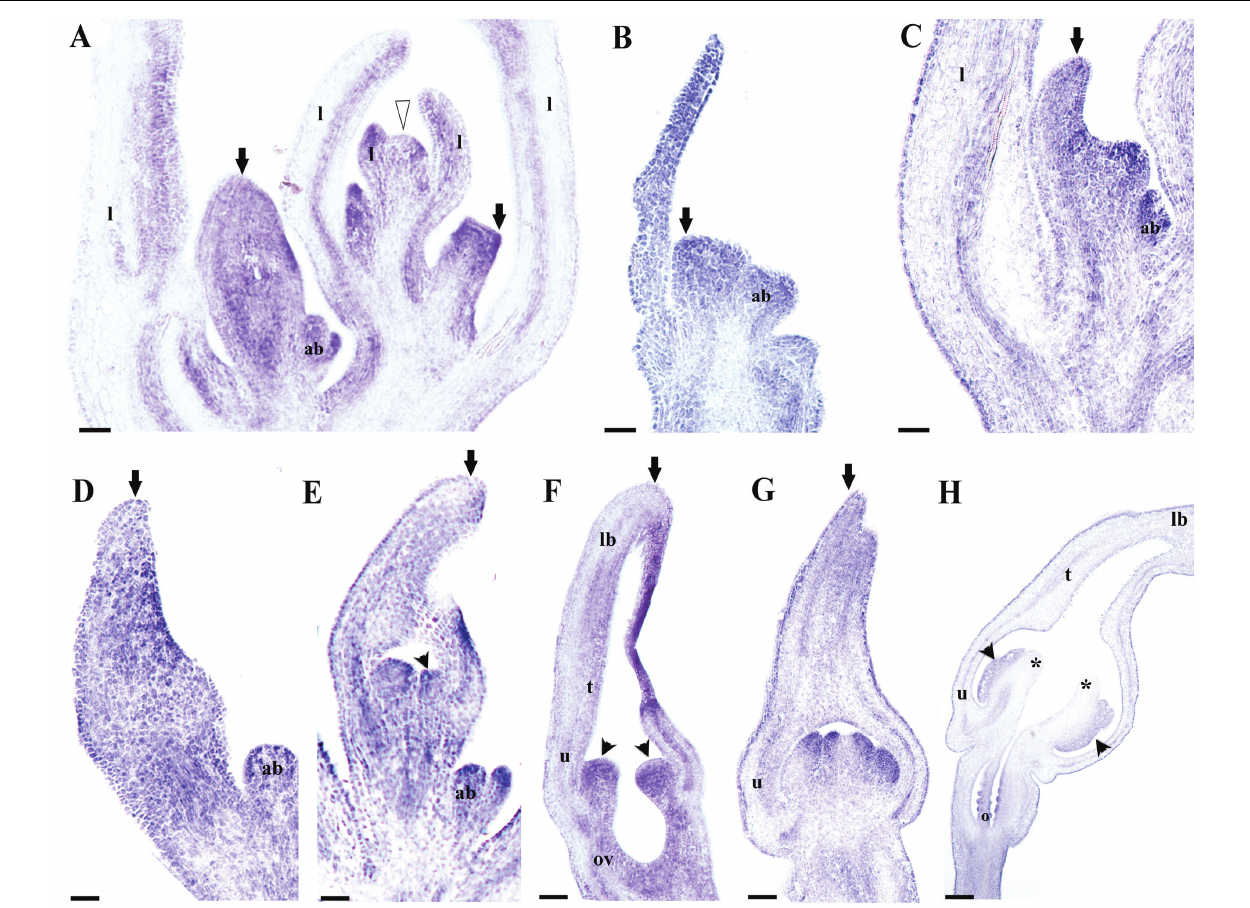
FIGURE 7 | In situ hybridization of AfimFUL. (A) Flowering shoot apex; note broad expression in floral stages S1 through S4. (B) Floral primordium. (C,D) Flower buds during perianth initiation and early elongation at S1–S2. (E,F) Stamen initiation at S3 (E) and elongation at S4 (F) ; note broad expression in perianth and gynostemium. (G,H) Gynostemium and ovary differentiation at S5 (G) and S7 (H) ; note late expression (in H ) restricted to perianth, anthers, and ovary. Black arrows indicate medial sepal; black arrowheads indicate anthers; white arrowhead indicates shoot apical meristem (SAM); asterisks indicate stigmas; ab, accessory bud; l, leaf; ov, ovary; o, ovules. Scale bars: (A–C) : 100 μ m; (D–H) : 200 μ